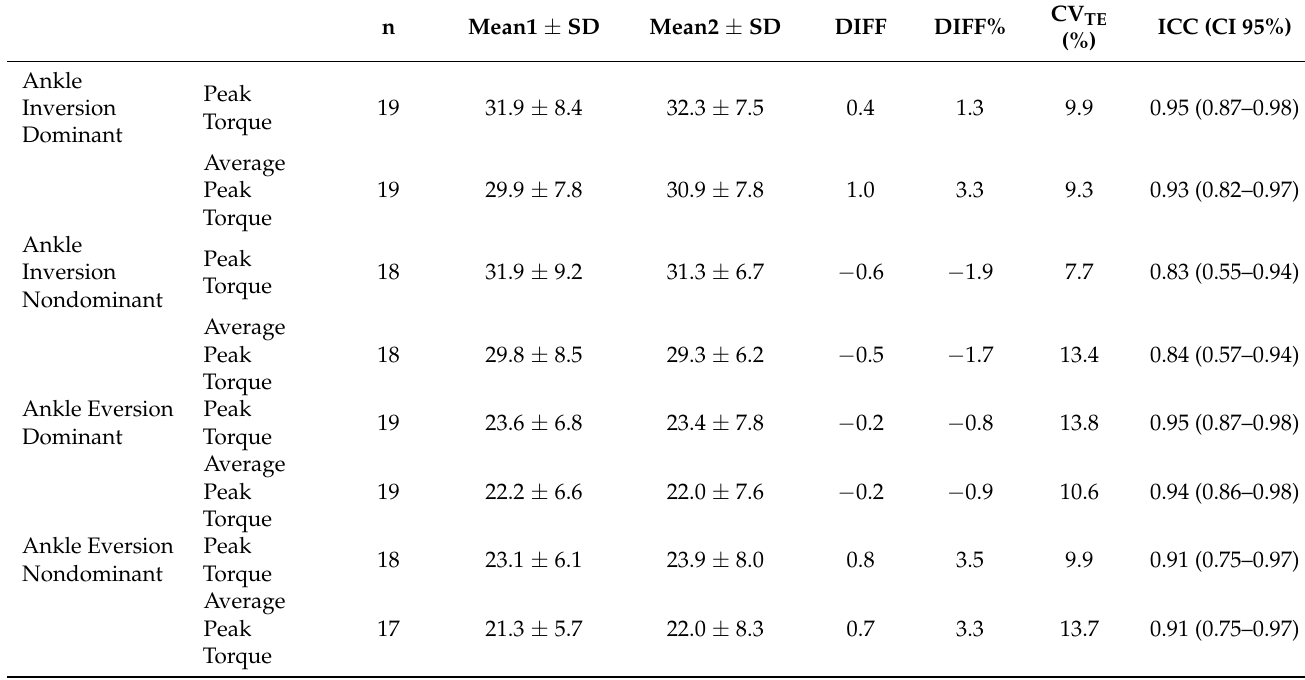
Table 2. Ankle inversion and